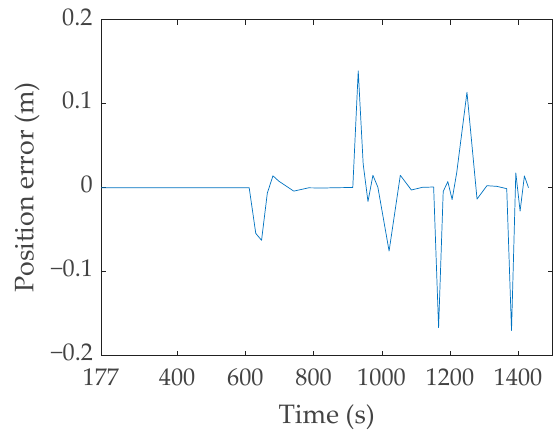
Figure 22. Cross-track position error for the AUV.